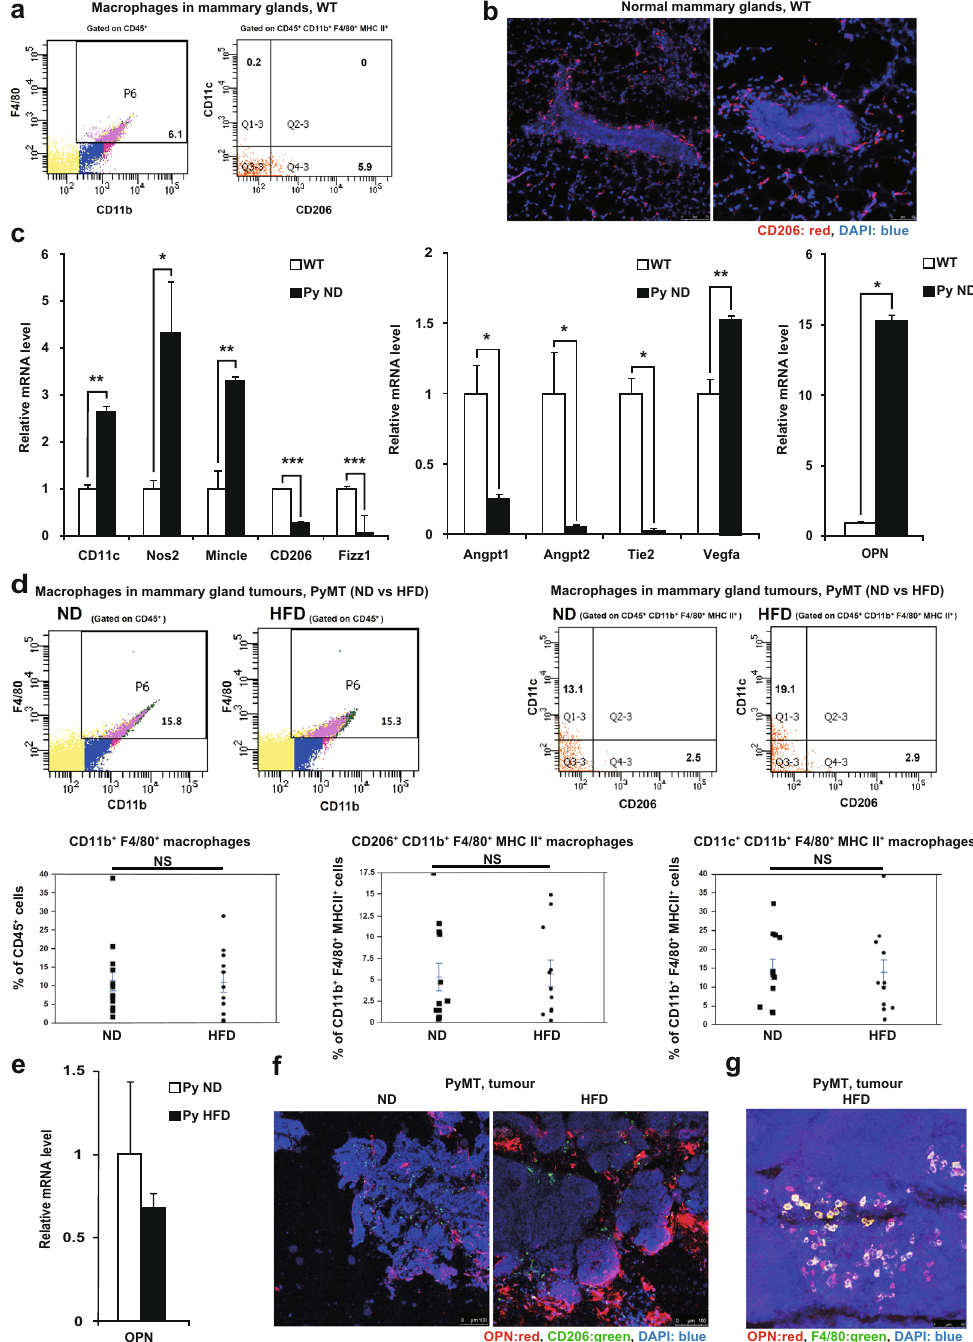
Figure 2. CD11c + M1-like macrophages are the major macrophage population in tumours, while CD206 + M2-like macrophages are the major resident macrophage population in the mammary gland. ( a ) Flow cytometric analysis of macrophage markers in mammary glands from WT mice at 20 weeks of age (n = 4). ( b ) Representative CD206 (red) immunostaining with DAPI (blue) staining of mammary glands from WT mice. ( c ) Quantitative RT-PCR analysis of the mRNA levels of macrophage markers and angiogenic markers in F4/80 + macrophages from the mammary glands of WT mice and from the tumour tissue of ND-fed PyMT mice (n = 3 per group). ( d ) Flow cytometric analysis of macrophage marker expression in tumours from ND-fed PyMT mice (n = 12) and HFD-fed PyMT mice (n = 11) at 20 weeks of age. ( e ) Quantitative RT-PCR analysis of Opn mRNA expression in F4/80 + macrophages from the tumours of ND-fed PyMT mice and HFD-fed PyMT mice (n = 3 per group). ( f ) Representative CD206 (green) and OPN (red) immunostaining with DAPI (blue) staining of tumours from ND-fed PyMT mice and HFD-fed PyMT mice. ( g ) Representative F4/80 (green) and OPN (red) immunostaining with DAPI (blue) staining of tumours from HFD-fed PyMT mice. Error bars indicate the s.e.m. * P < 0.05, ** P < 0.01 and *** P < 0.001; NS, not